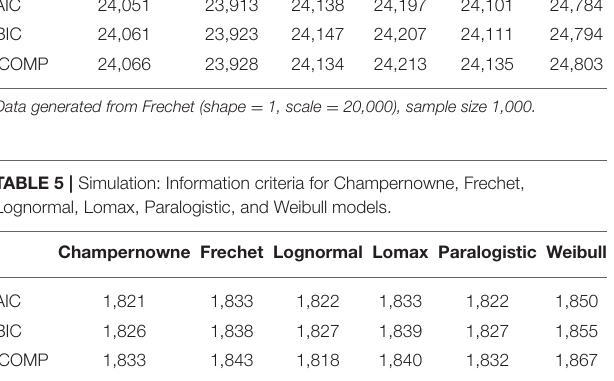
Data generated from Lognormal (location = 7, scale